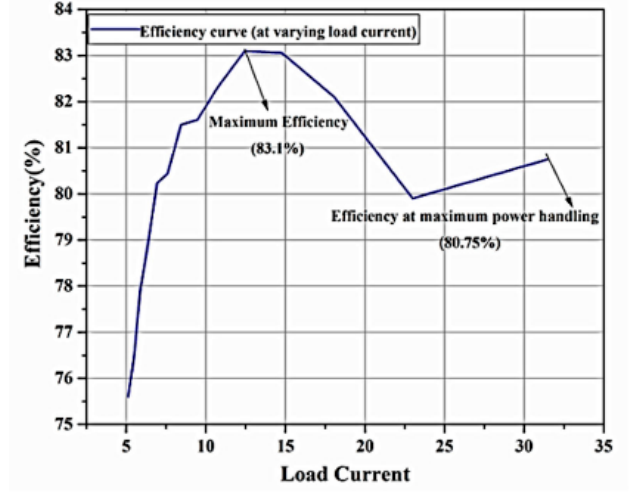
Figure 17. Efficiency vs. load current (at different loading conditions).